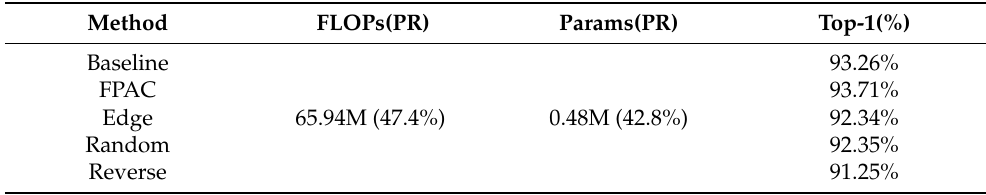
Table 3. Ablation experiments results of ResNet-56 on CIFAR-10. “Top-1”: accuracy.